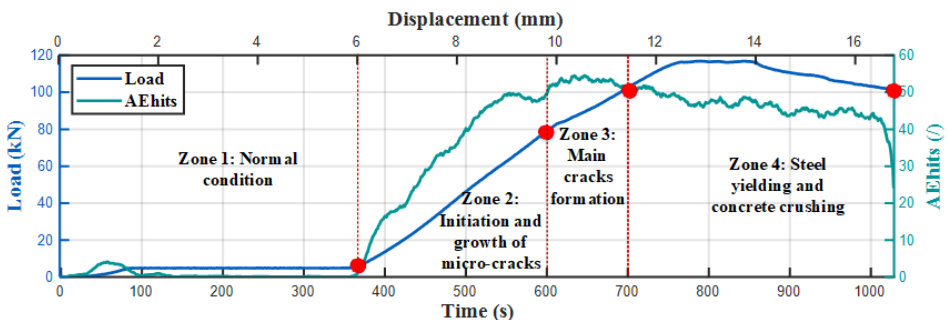
Figure 3. Damage progression in an RC beam during a bending test.